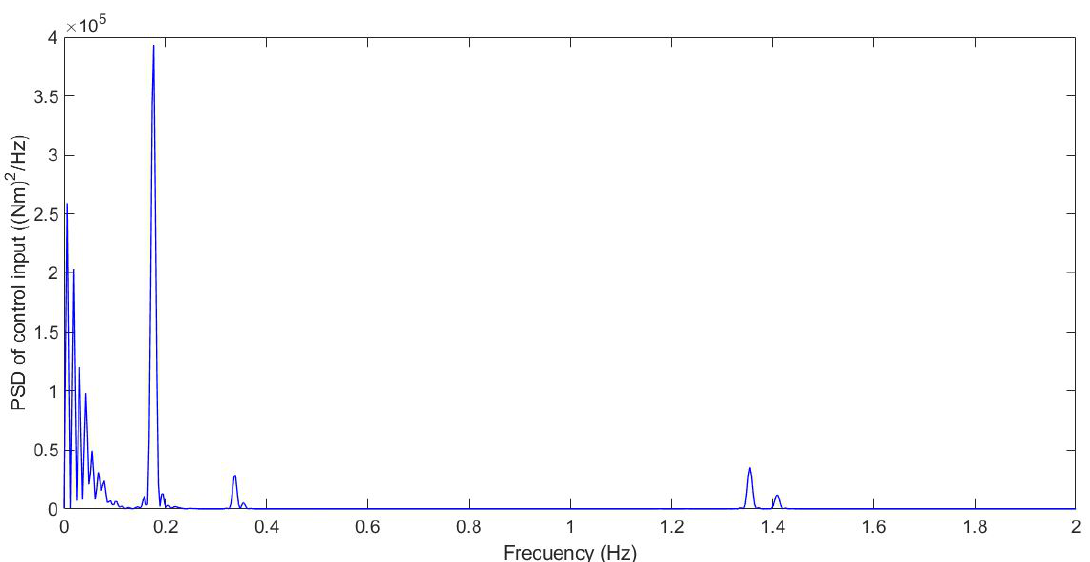
Figure 14. Frequency response for test 1: Roundabout at 30